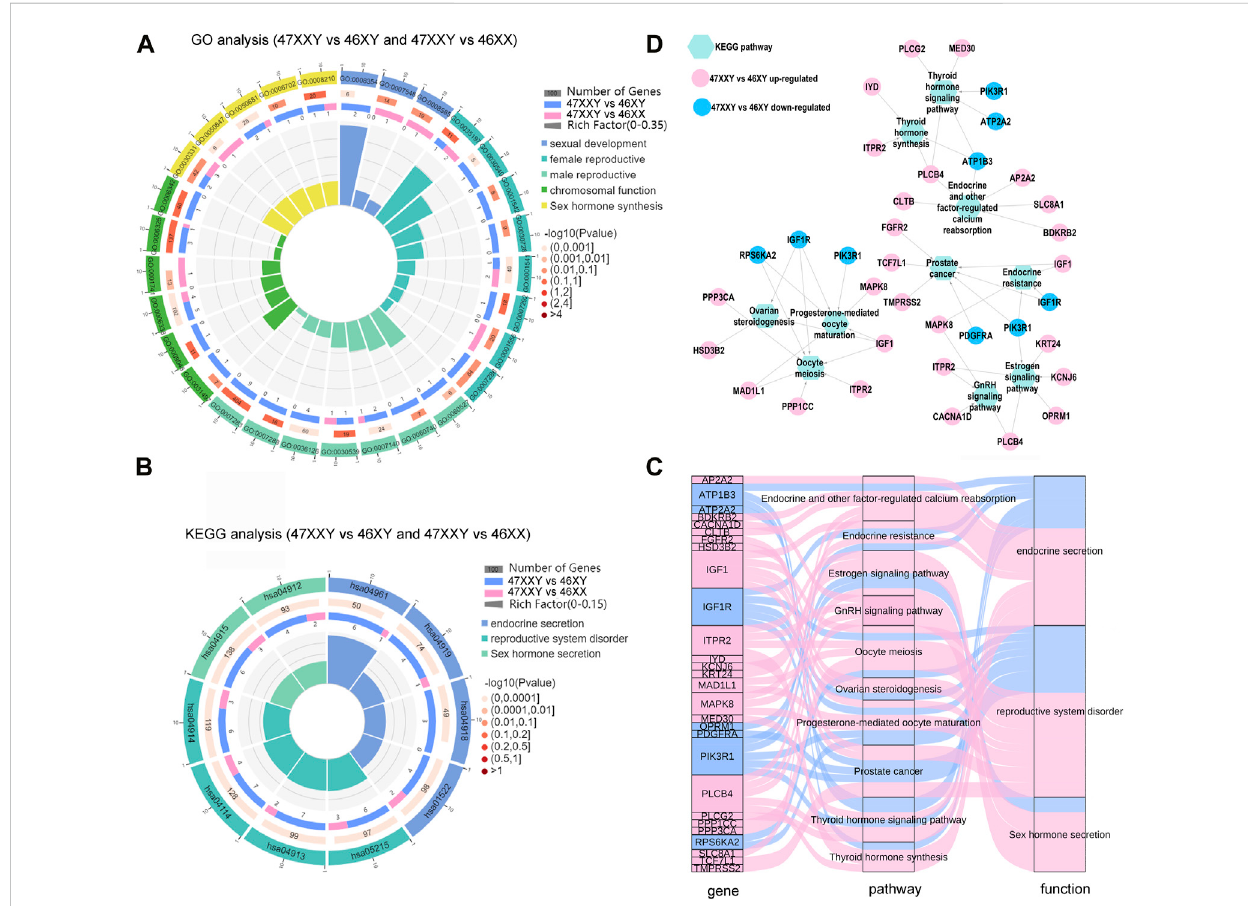
FIGURE 7 The hormone secretion pathway of the overlapped genes in WGBS and ATAC-seq. (A) Comparison analysis of GO items of sexual related biological process in 47XXY vs. 46XY and 47XXY vs. 46XX. (B) Comparison analysis of hormone secretion related KEGG pathways in 47XXY vs. 46XY and 47XXY vs. 46XX. Classi fi ed as 3 functions: 1. Endocrine secretion (Endocrine and other factor-regulated calcium reabsorption, Endocrine resistance, Thyroid hormone signaling pathway and Thyroid hormone synthesis); 2. Sex hormone secretion (Estrogen signaling pathway, GnRH signaling pathway); 3. reproductive system disorder (Oocyte meiosis, Ovarian steroidogenesis, Prostate cancer, Progesterone-mediated oocyte maturation) (C) Sanky map of overlapped genes in different pathways. (D) Network of the genes (47XXY vs. 46XY and 47XXY vs. 46XX) in different hormone secretion